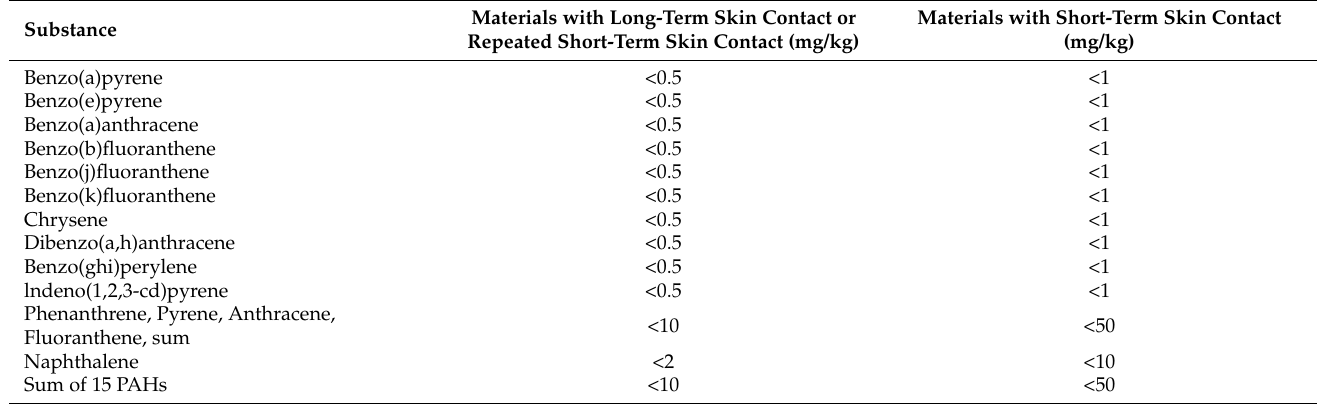
Table 2. PAHs limit values specified in the GS specification by the AfPS